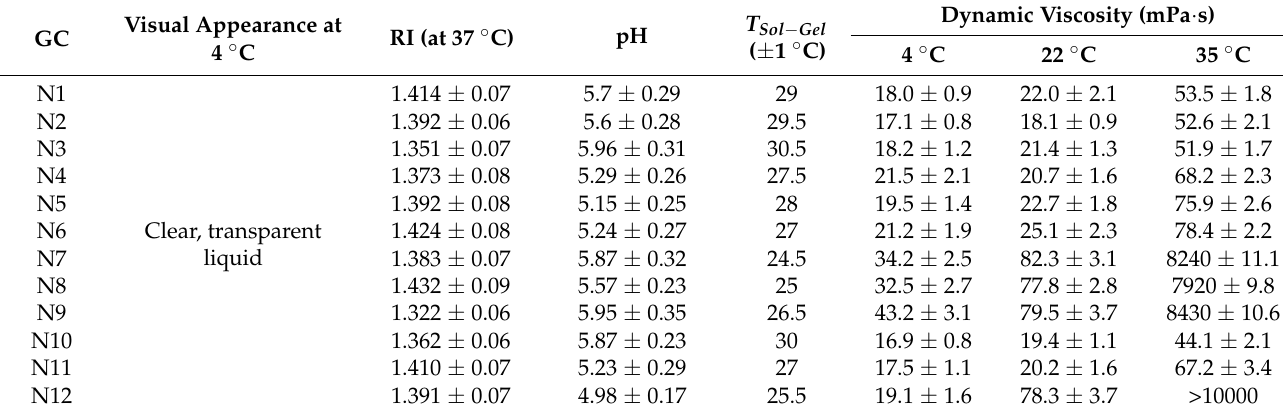
Table 5. Physicochemical properties of the prepared in situ gels. Data represent mean standard deviation (SD), n = 3. Visual Appearance GC